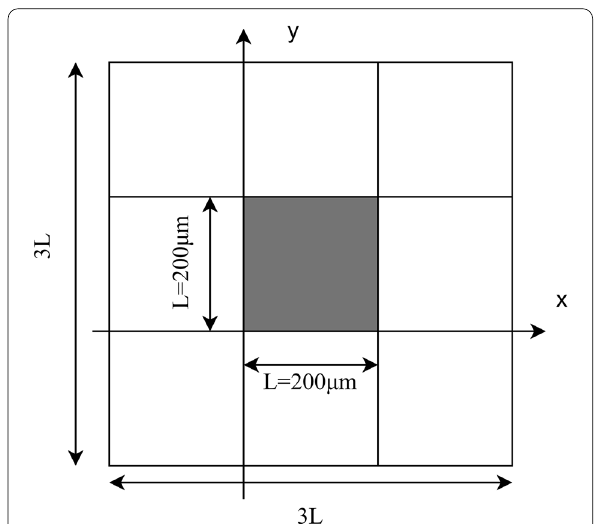
Fig. 8 Schematic diagram of the cyclic boundary processing of the